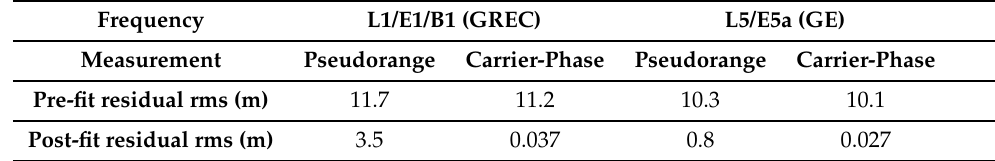
Table 11. Pre-fit and post-fit residual rms for single- and dual-frequency PPP